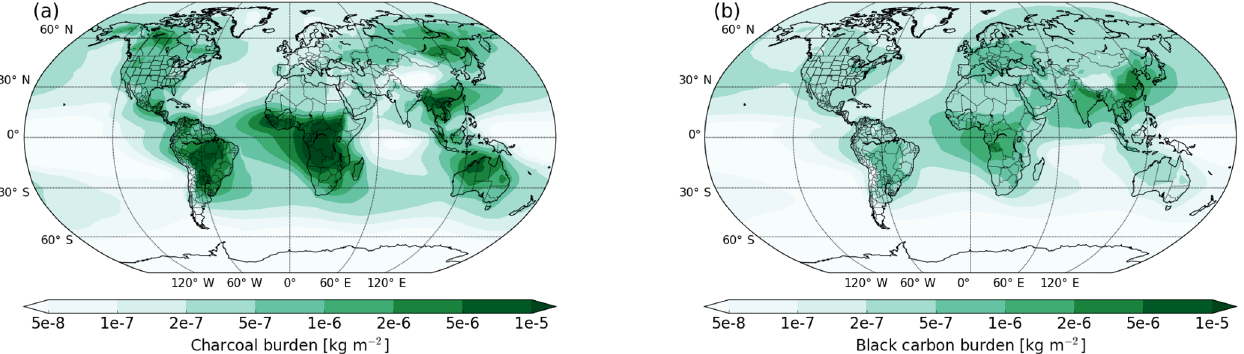
Figure 5. Simulated aerosol burden averaged over 10 years for (a) charcoal and (b) black carbon. For the charcoal burden, only particles above the threshold radius of r eq = 4 . 9µm are considered. A charcoal emission number geometric mean radius of r eq = 5µm and a charcoal density of 0 . 6g cm − 3 were used.